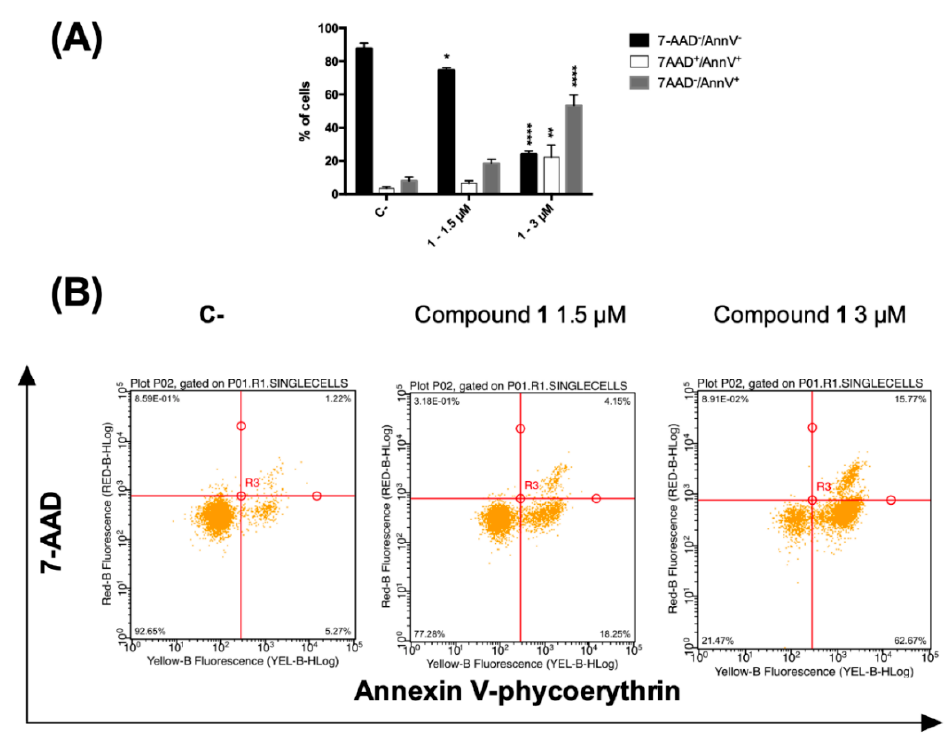
Figure 4. ( A ) Percentage and ( B ) representative dot plot of 7-AAD − / annexin V − , 7AAD + / annexin V + and 7-AAD − / annexin V + cells after 24 h treatment of CCRF–CEM cells with compound 1 . * p < 0.05, ** p < 0.01, **** p < 0.0001 versus untreated cells. C-: control.